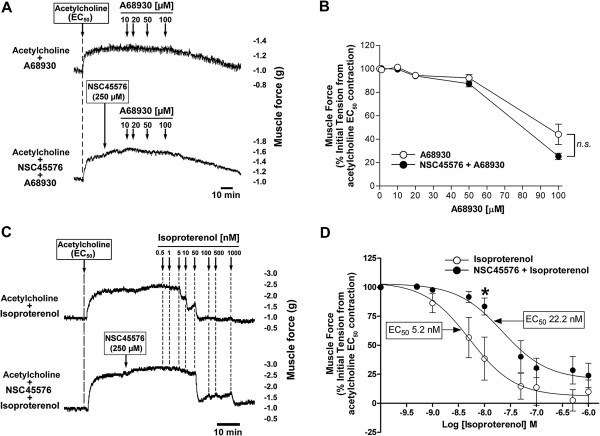
Dopamine D1 receptor-mediated guinea pig airway relaxation is Epac independent. (A) Representative tension tracing in guinea pig tracheal ring after an acetylcholine contraction followed by increasing concentrations of the dopamine D1-like receptor agonist A68930 (1 - 100 μM) in the presence or absence of the Epac antagonist NSC45576 (250 μM). Top tracing is A68930 alone, and bottom tracing represent treatment with A68930 after 15 min pretreatment with NSC45576. (B) The effect of pretreatment with NSC45576 (250 μM) on A68930 (1 - 100 μM)-mediated tracheal ring relaxation. Open circles: A68930 alone. Filled circles: NSC45576 + A68930. Means ± SEM. N = 4. (C) Representative tension tracing in guinea pig tracheal ring after an acetylcholine contraction followed by increasing concentrations of β-adrenoceptor agonist isoproterenol in the presence or absence of NSC45576 (250 μM). Top tracing is isoproterenol alone, and bottom tracing represent treatment with isoproterenol after 15 min pretreatment with NSC45576. (D) Isoproterenol concentration-response curves comparing treatment with isoproterenol alone (open circles) to isoproterenol after pretreatment with NSC45576 (250 μM) (filled circles). *P < 0.05 compared with isoproterenol alone. N = 5.